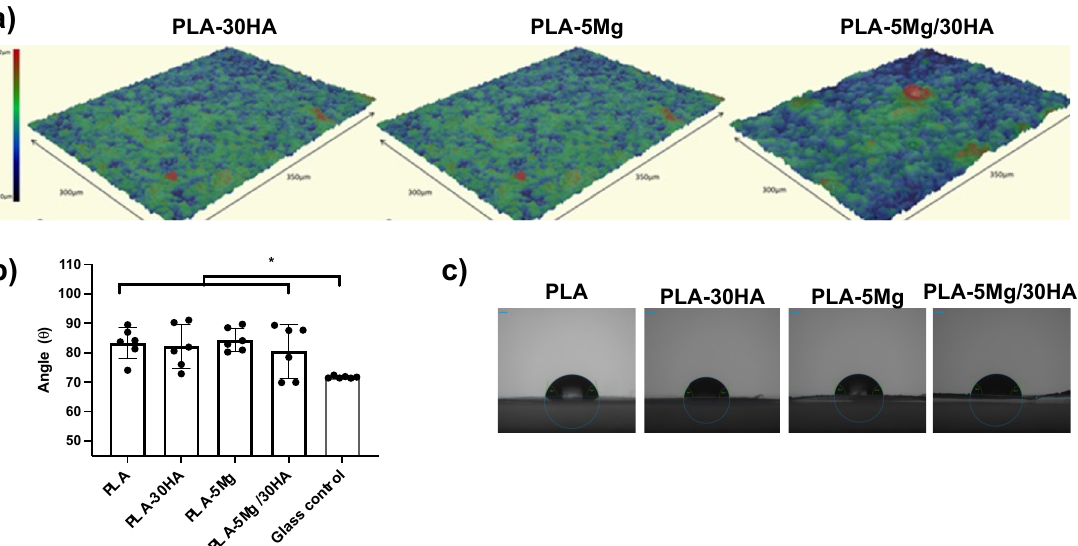
Figure 5. Membranes surface properties. ( a ) Topography images of the membrane surface of the PLA composites. ( b ) Water contact angle measurements performed on different surfaces and ( c ) representative pictures ( n = 6 replica per surface).